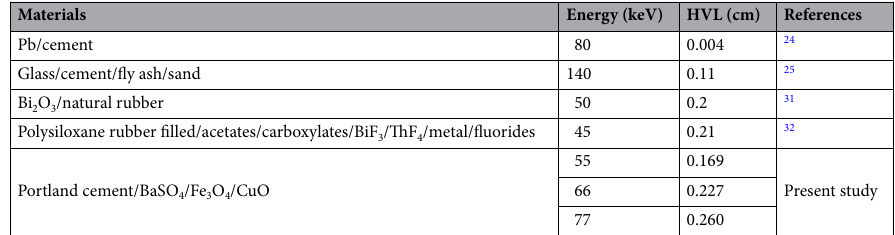
Materials Energy (keV) HVL (cm) References Pb/cement 80 0.004 24 Glass/cement/fly ash/sand 140 0.11 25 Bi 2 O 3 /natural rubber 50 0.2 31 Polysiloxane rubber filled/acetates/carboxylates/BiF 3 /ThF 4 /metal/fluorides 45 0.21 32